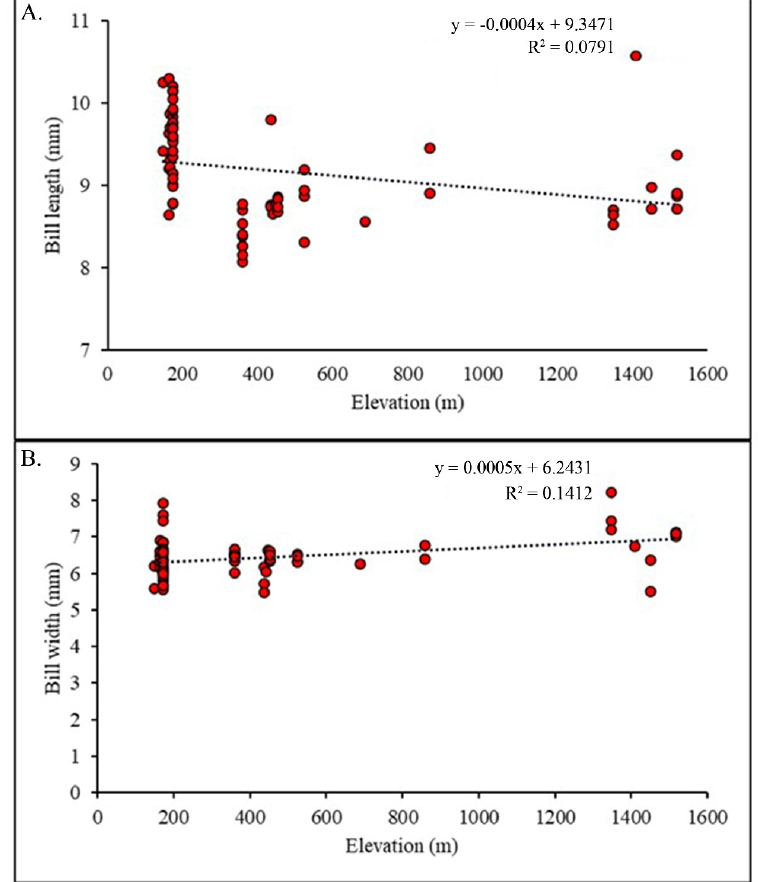
Figure 5. Bill length and width as a function of elevation in Passer domesticus . ( A ). Bill length vs. elevation, and ( B ). Bill width vs. elevation.